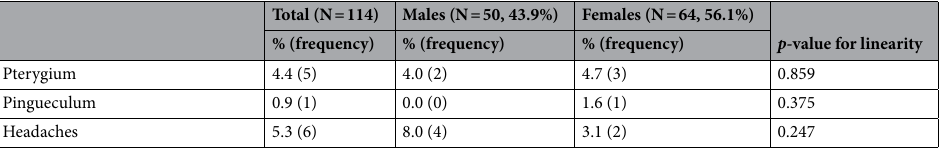
Table 2. Clinical characteristics of external ocular and periocular infections among a Ghanaian ophthalmic population. FFL fixate-and-follow light, PERLLA pupils are equal, round, and reactive to light and accommodation, RAPD relative afferent pupillary defect.